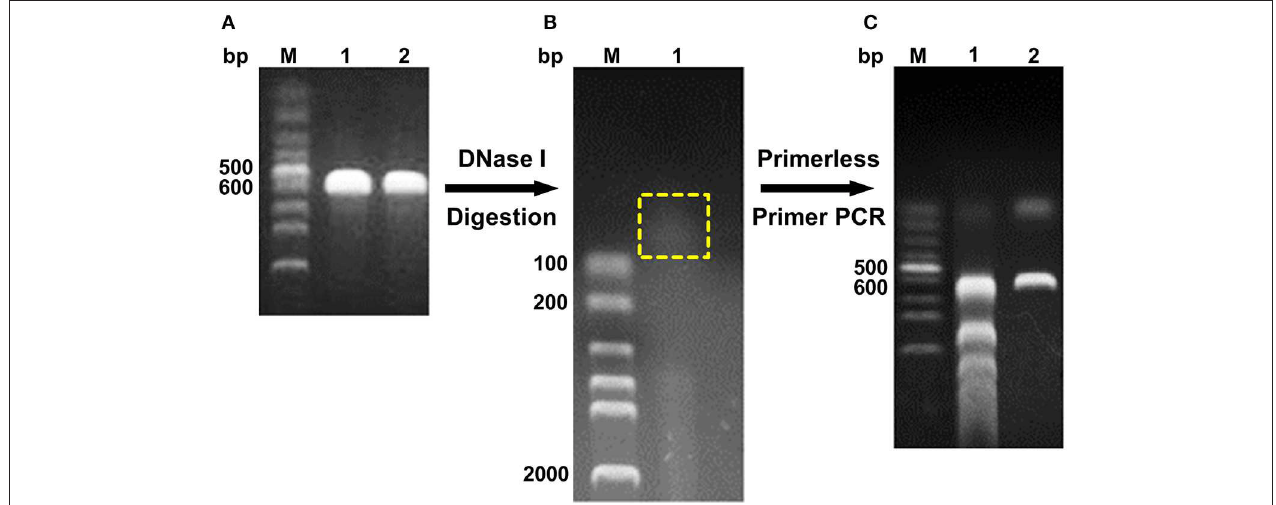
FIGURE 1 | Schema of DNA shuffling. (A) PCR products of baxa and tfxa_cd gene. M, Lane 1, and 2 were DNA marker, baxa, and tfxa_cd gene, respectively. (B) Digestion of baxa and tfxa_cd gene by DNaseI. The digestion products in the yellow box were recovered. (C) Primerless/primer PCR product. Lane 1 was